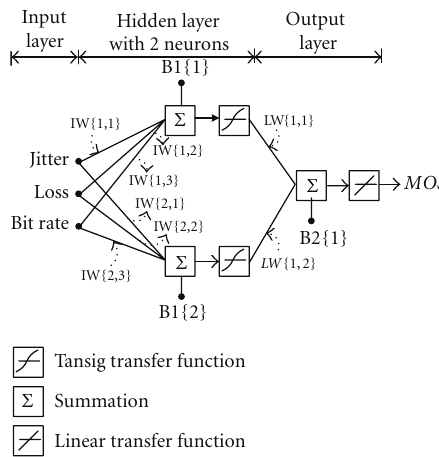
Figure 9: Neural network architecture showing model